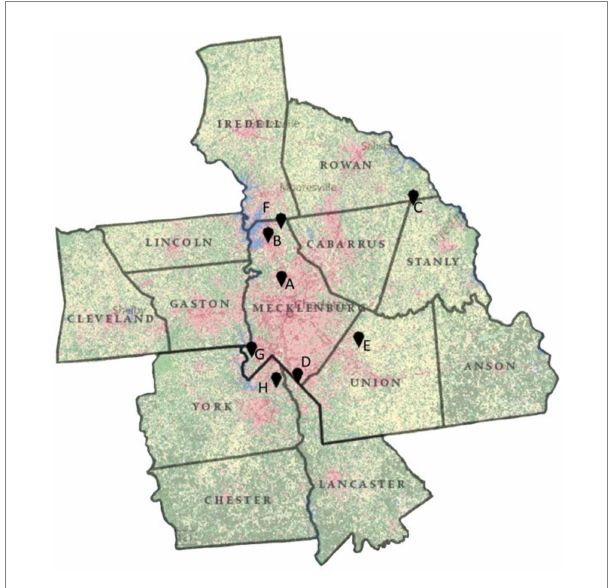
FIGURE 1 The Charlotte Metropolitan Area, USA with pellet collection sites identified by lettered markers and counties indicated by name. Developed land is shown in shades of red, open water is blue, forest types are in shades of green, and pasture, grassland, and cultivated crops are in shades of yellow (Dewitz and United States Geological Survey,